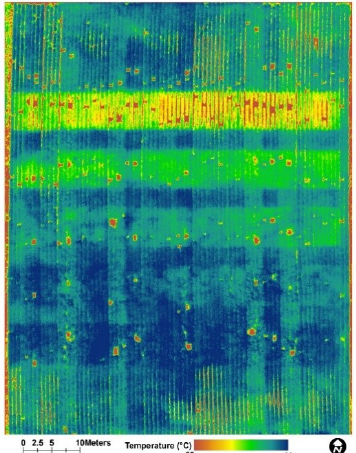
Figure 8. Spatial distribution of canopy temperature derived from UAV thermal imagery on 20 July 2017, which shows stress development from north to south of the field from 0.3 m rooting depth to 0.45 m, 0.6 m,